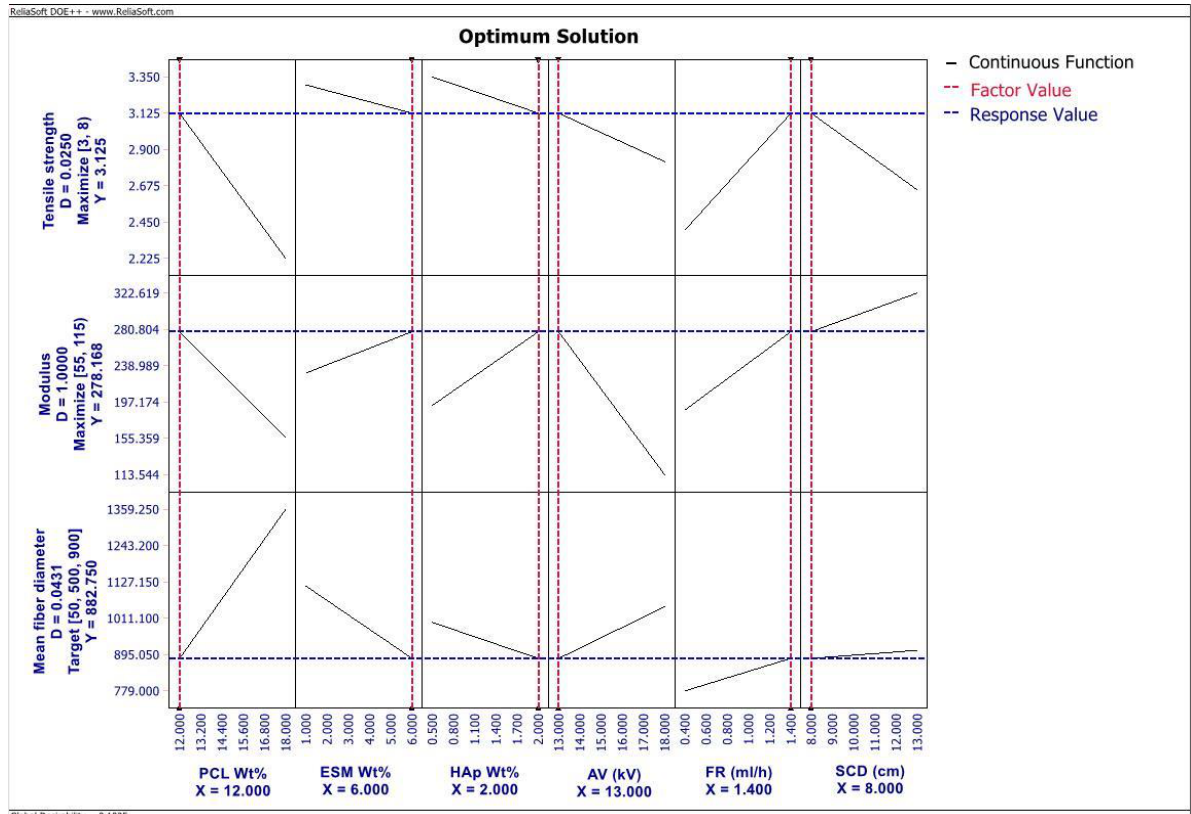
Figure 5. The optimal solution for maximizing the mechanical properties and MFD values of an electrospun composite membrane.